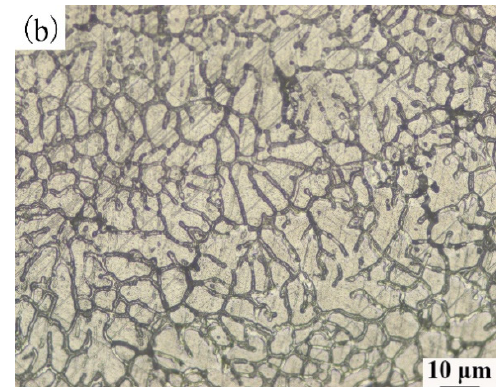
Figure 8. Mean grain diameter of OABs for different overcurrents.